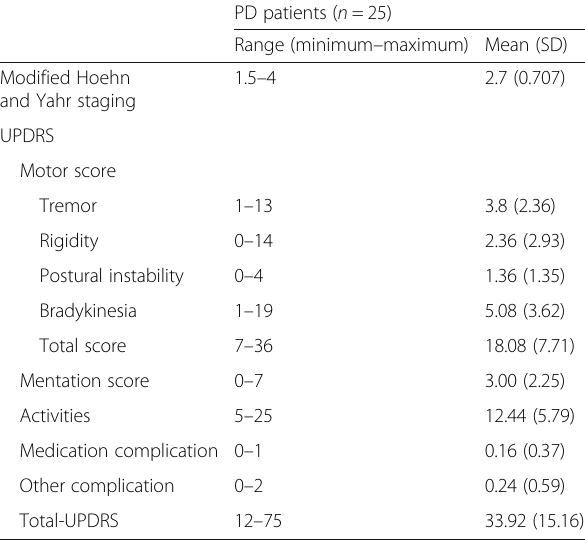
Table 2 Modified Hoehn and Yahr staging and UPDRS score for PD patients